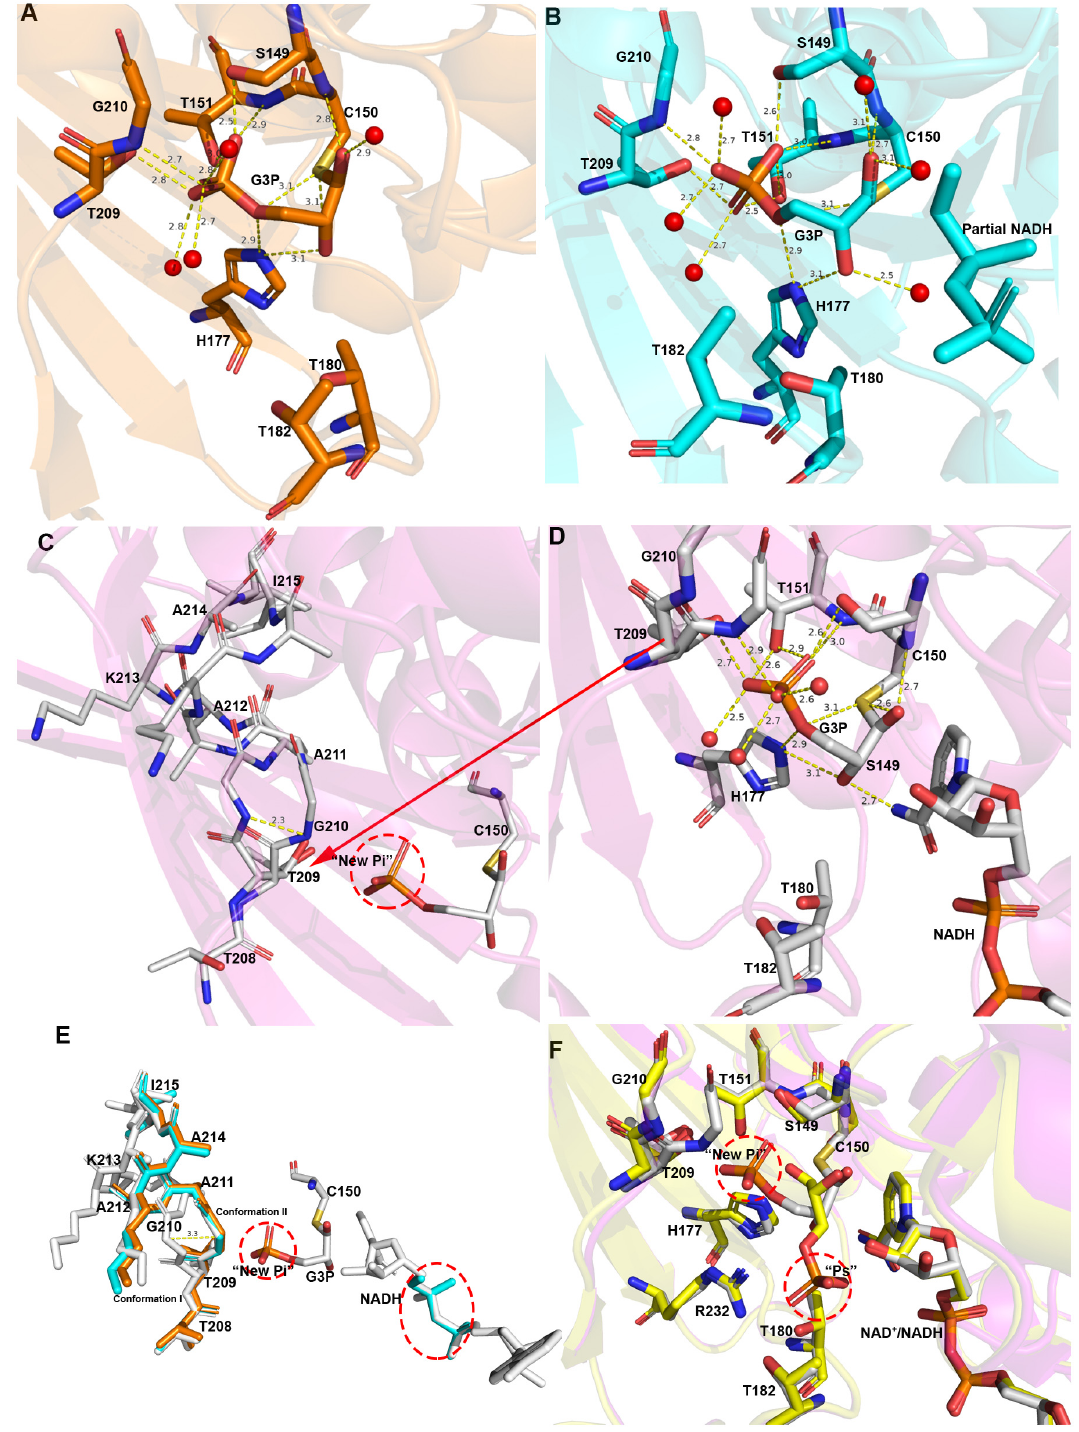
Figure 4. Structure of the thioacyl intermediate of wild-type Ec GAPDH1. ( A , B , D ) NADH and G3P in the P subunit (orange), R subunit (cyan), and Q subunit (magenta) of the thioacyl intermediate of wild-type Ec GAPDH1 (7C7K). Amino acids interacting with G3P are shown as sticks and hydrogen bonds are shown as yellow dotted lines. The Q subunit contains complete NADH, the R subunit contains partial NADH, and the P subunit does not contain any NADH. ( C , D ) Two different loop conformations composed of amino acid residues 208 − 215. ( E ) Superimposition of the loop conformation, NADH, and active amino acid interacting with G3P from the above-mentioned structure. The different parts are highlighted in red. ( F ) Superposition of the amino acids interacting with G3P of the Q subunit of the thioacyl complex with the P subunit of C151S.NAD.G3P. The thioacyl complex is shown in magenta, while C151S.NAD.G3P is shown in